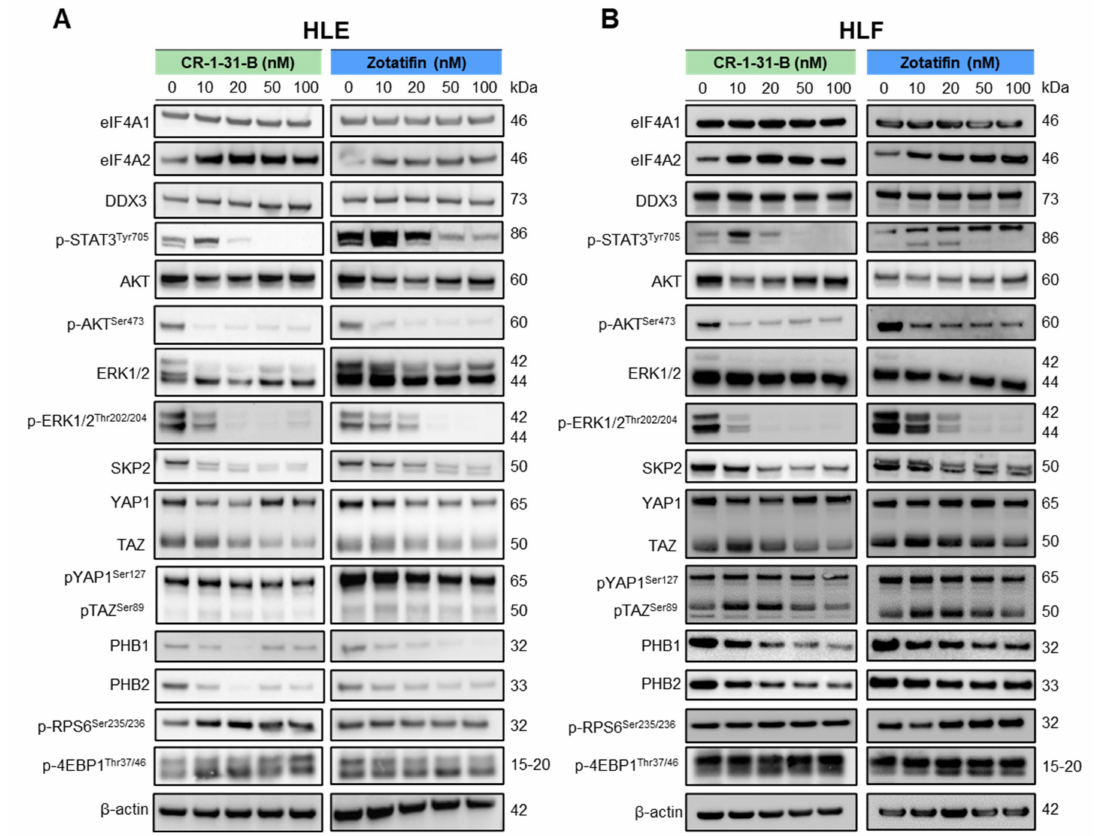
Figure 9. Effects of the eIF4A inhibitors, CR-1-31-B and Zotatifin, in HCC cell lines on the levels of elements of oncogenic pathways involved in hepatocarcinogenesis. Western blot analysis was used to assess the levels of several effectors of oncogenic cascades in HLE ( A ) and HLF ( B ) cell lines exposed to increasing concentrations of CR-1-31-B and Zotatifin inhibitors (0, 10, 20, 50, and 100 nM). Cells were treated for 48 h, and western blot analysis was conducted at this time